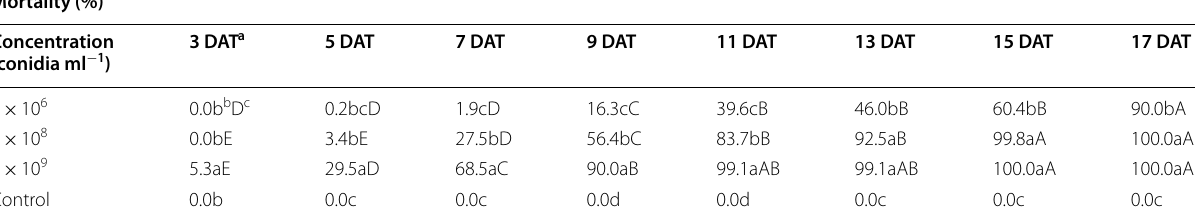
a DAT: Days after treatment b Means in a column followed by the same letter are not statistical significantly different (ANOVA P < 0.05, Tukey’s test) c Means in a line followed by the same capital letter are not statistical significantly different (ANOVA P < 0.05, Tukey’s test)